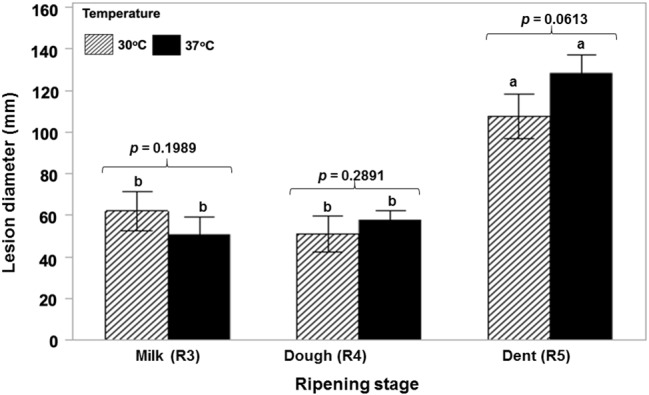
Relative colonization rates of maize cobs of different ripening ages (R3, R4, R5) by a toxigenic strains of A. flavus (NRRL 3375) when point inoculated and incubated at the water activity levels of the different growth stages at 30 and 37°C. Statistical test performed after lesion diameter (mm) data was transformed to Log(x + 1) to achieve normality fit (Shapiro Wilk p ≥ 0.05). The values of p indicate no difference between temperatures. Treatments with the same letters indicate no differences in the ripening stages based on the Tukey’s HSD test (p ≥ 0.05).